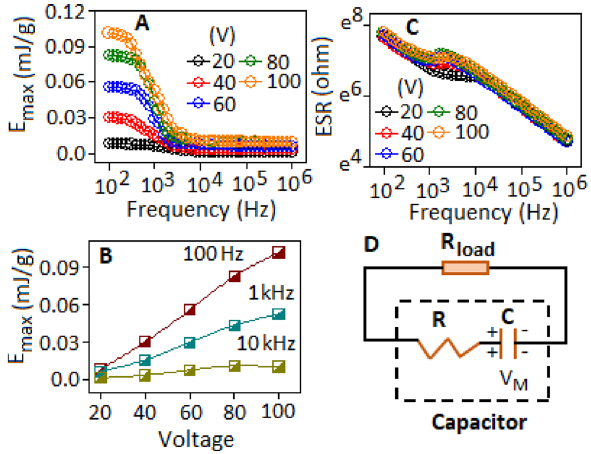
Figure 6. ( A ) Variation of energy density (E max ) with respect to frequency, under DC-voltage, ( B ) energy density (E max ) as a function of voltages under different frequency condition, ( C ) equivalent series resistance (ESR) as a function of frequency under different voltage condition (in log–log scale), ( D ) equivalent circuit representation for the energy and power transfer model at a certain voltage (V M ), for the FALS based device.